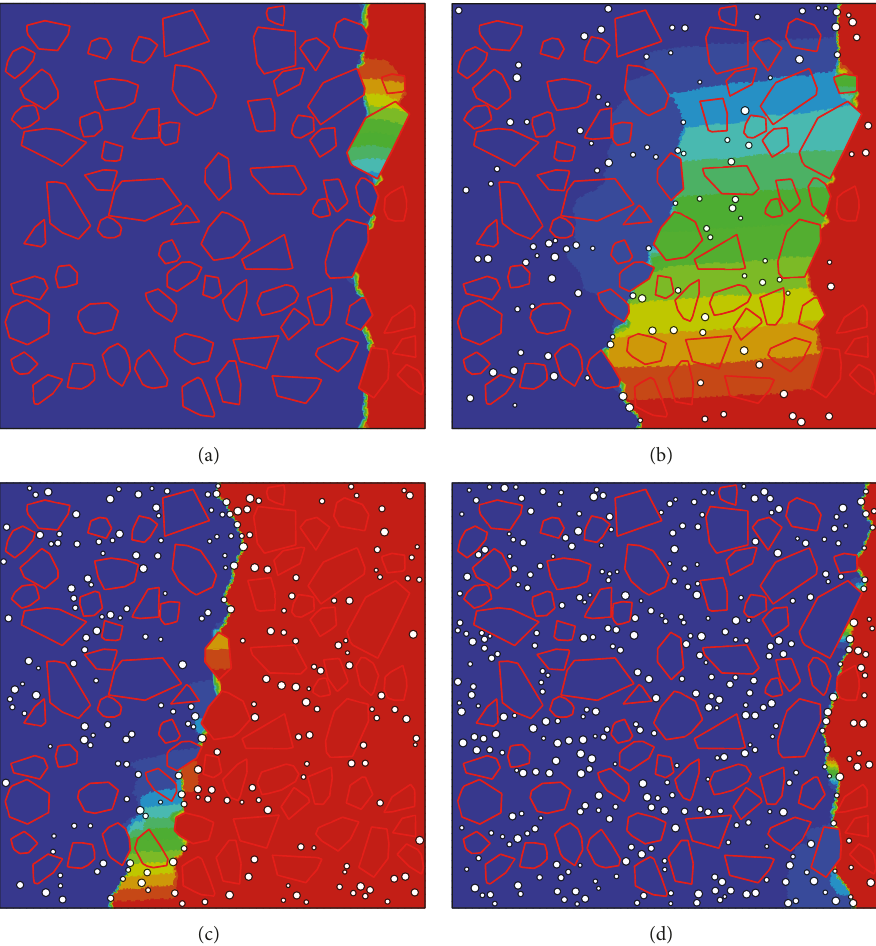
Figure 13: Fracture patterns of concrete specimens with 𝐴 𝐹 = 30 % for (a) 𝐴 V = 0 %; (b) 𝐴 V = 2 %; (c) 𝐴 V = 4 %; (d) 𝐴 V = 6